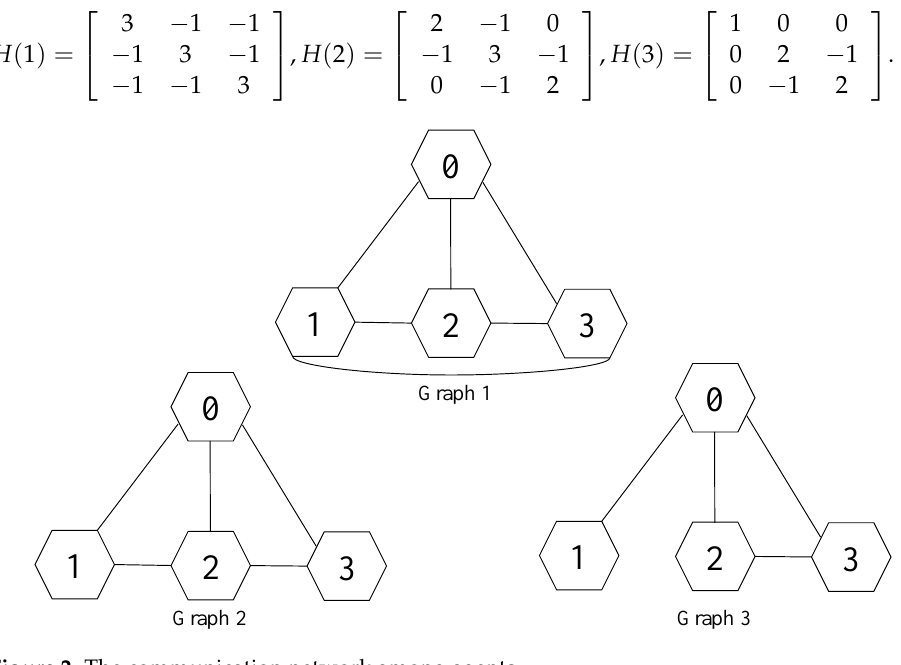
Figure 2. The communication network among agents.